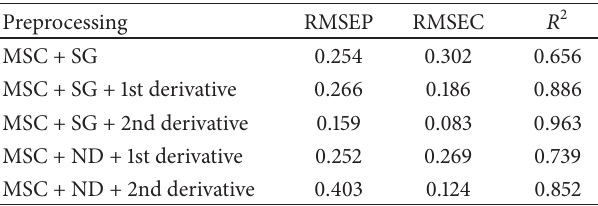
Table 4: Optimization of spectra processing in carlibration models.